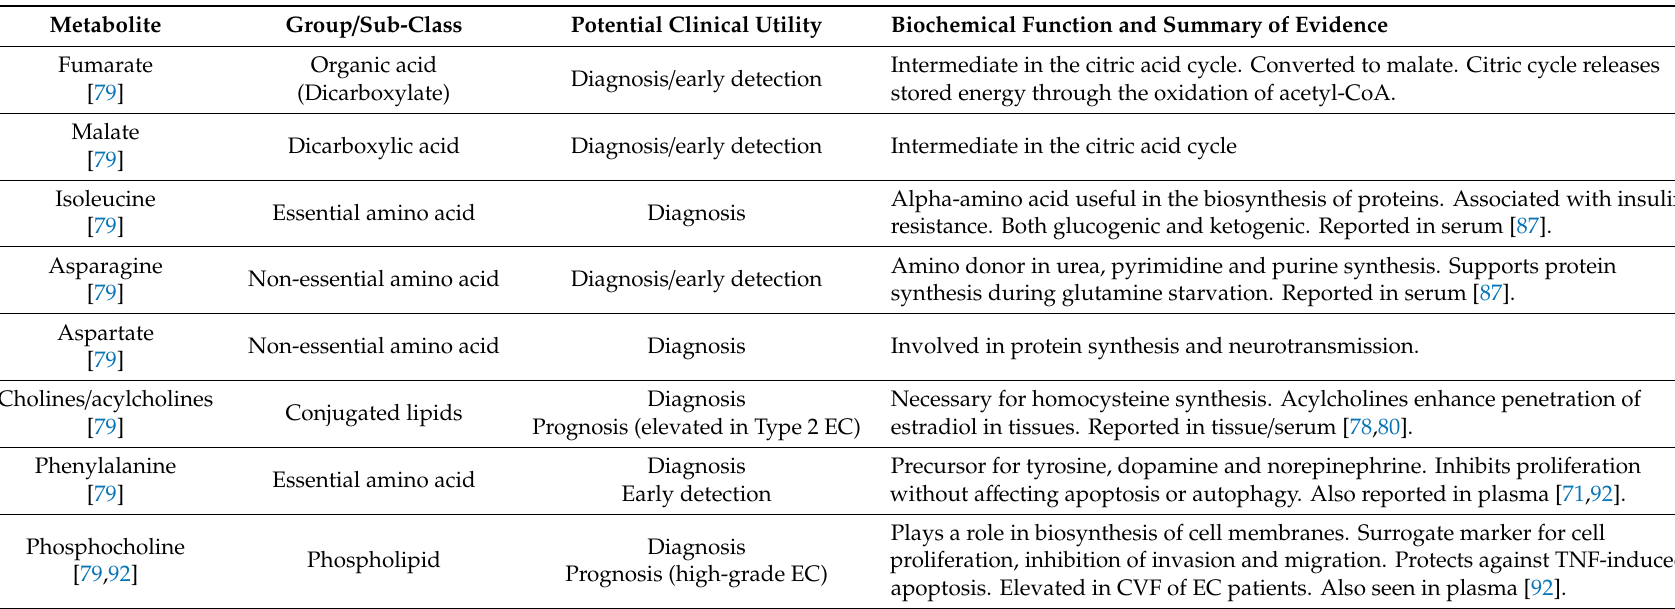
Table 4. Most promising cervicovaginal fluid-based EC metabolomic biomarker candidates and their